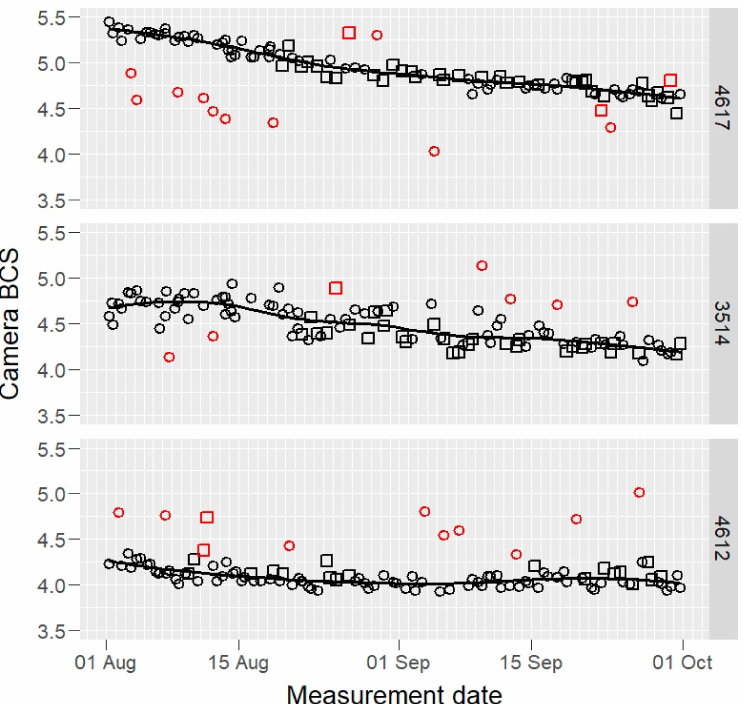
Figure 1. Raw camera body condition score (BCS) values of three selected cows (4617, 3514, and 4612: maximum, median, and minimum BCS mean value cows) by two cameras (open squares and circles) during the experiment, on 1–8 scale. The fitted solid line is a robust loess smooth curve that was used to identify the outliers (red open squares and circles).